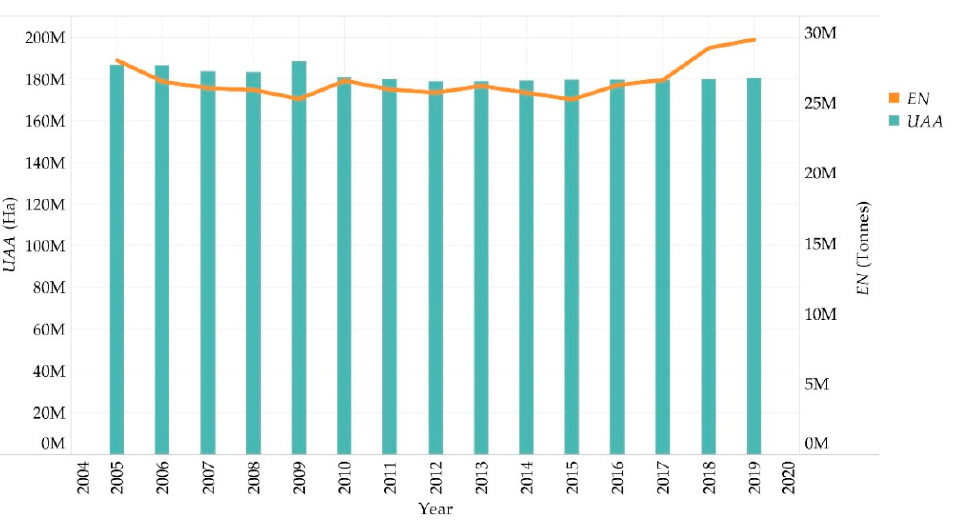
Figure 4. Total Used Agricultural Area ( UAA ) and Energy consumption in agriculture ( EN) for the period 2005–2019.